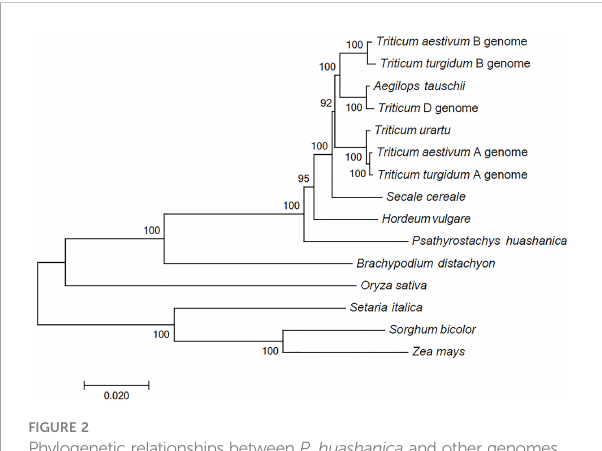
(Figure 5E). The transitions-to-transversions ratio was 1.69:1, which re fl ected the genetic conservation during evolution.